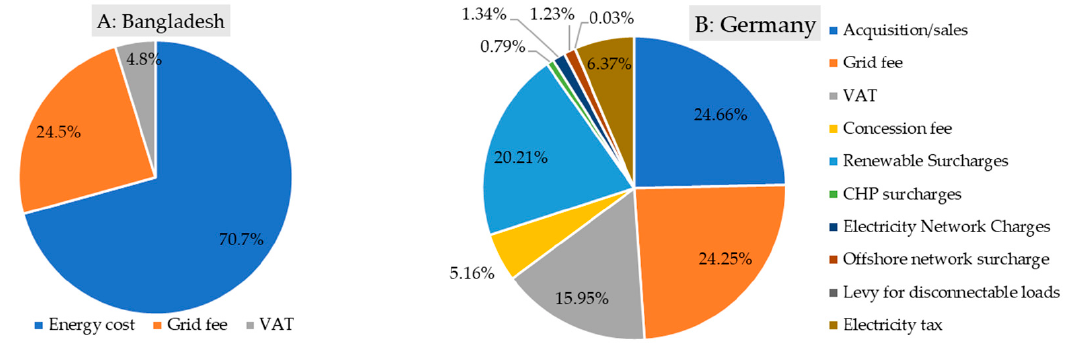
Figure 3. Components of retail electricity tariffs in Bangladesh ( A ) and Germany ( B ). Data source: Bangladesh—an average consumer tariff charged by BPDB in 2020 [36]; German tariff for the resi- dential consumers in 2021 [37].